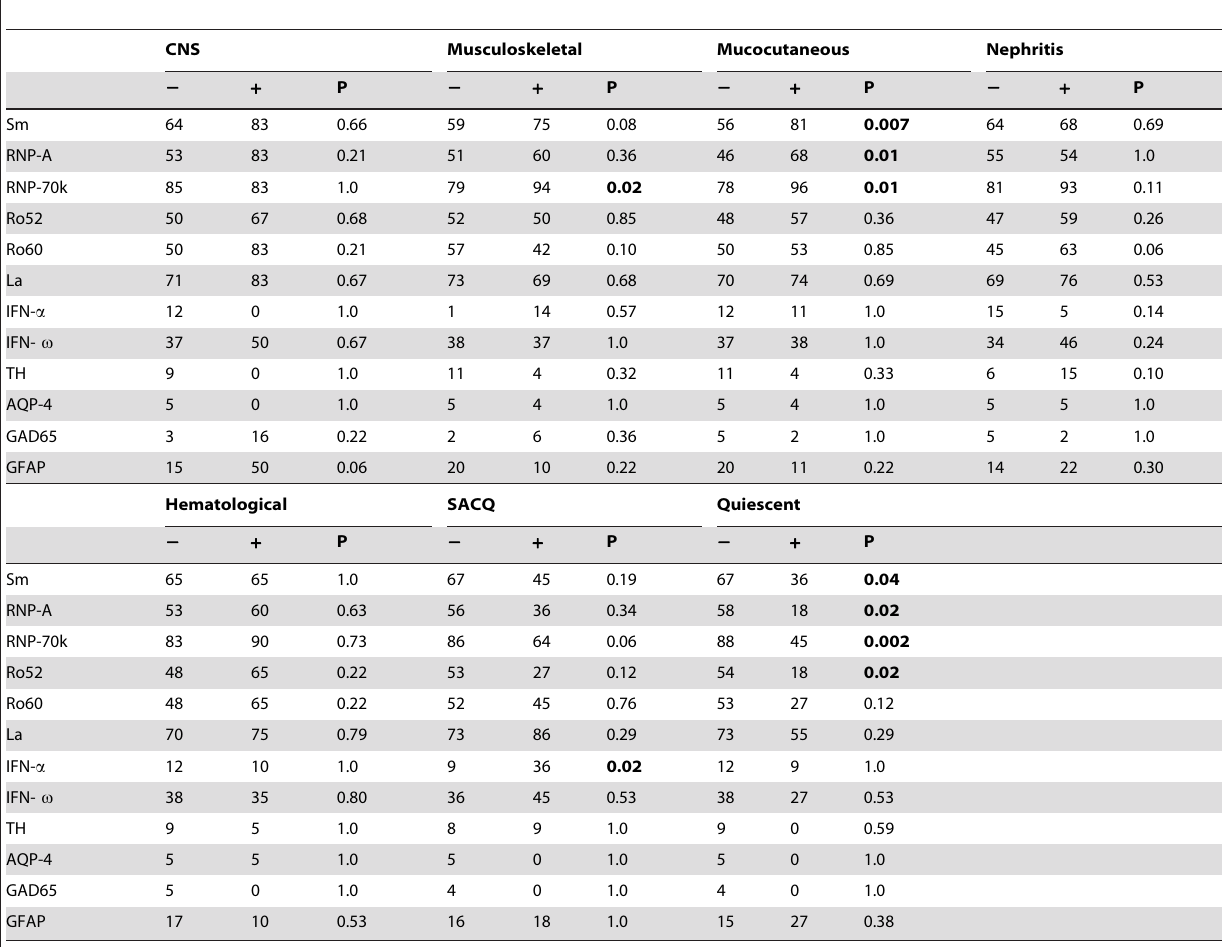
Table 4. Percentage of autoantibody positive patients by a given clinical manifestation.